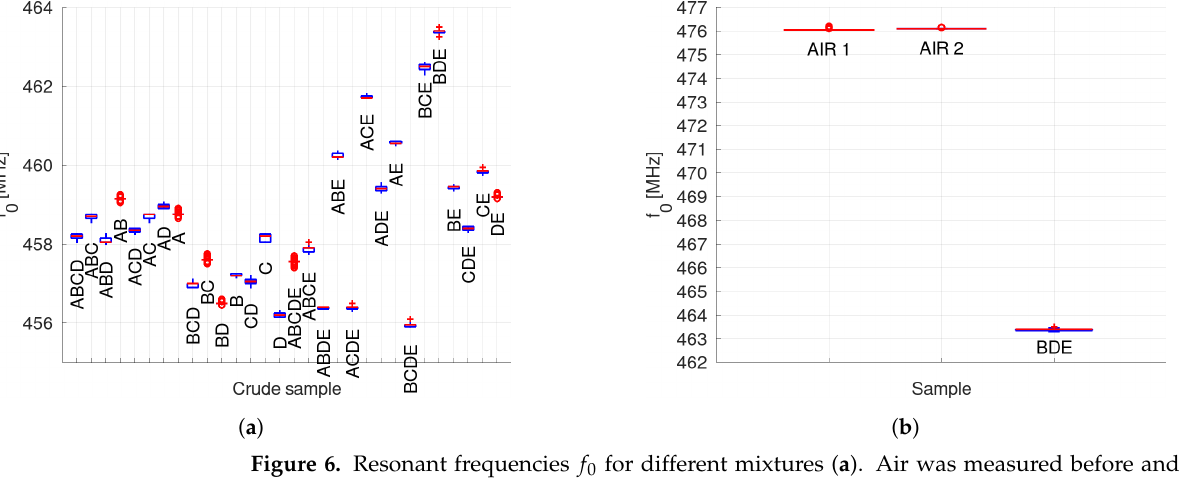
Figure 6. Resonant frequencies f 0 for different mixtures ( a ). Air was measured before and after the crudes ( b ). Since the same resonant frequency was obtained, the SRR sensor survived all the measurements between without any damage or substrate contamination. BDE sample is also shown.